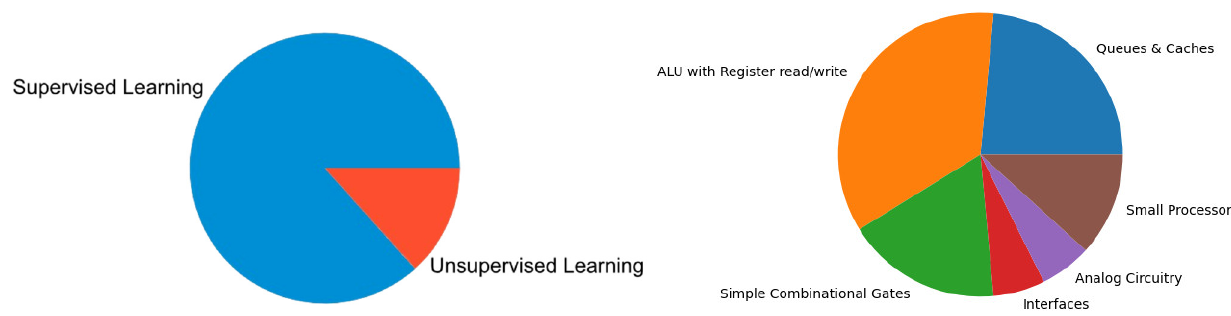
Figure 4. ( Left ): Distribution of supervised and unsupervised ML models in “Stimulus and Testcase Generation” category. ( Right ) Distribution of used RTL designs for validating proposed ML models.